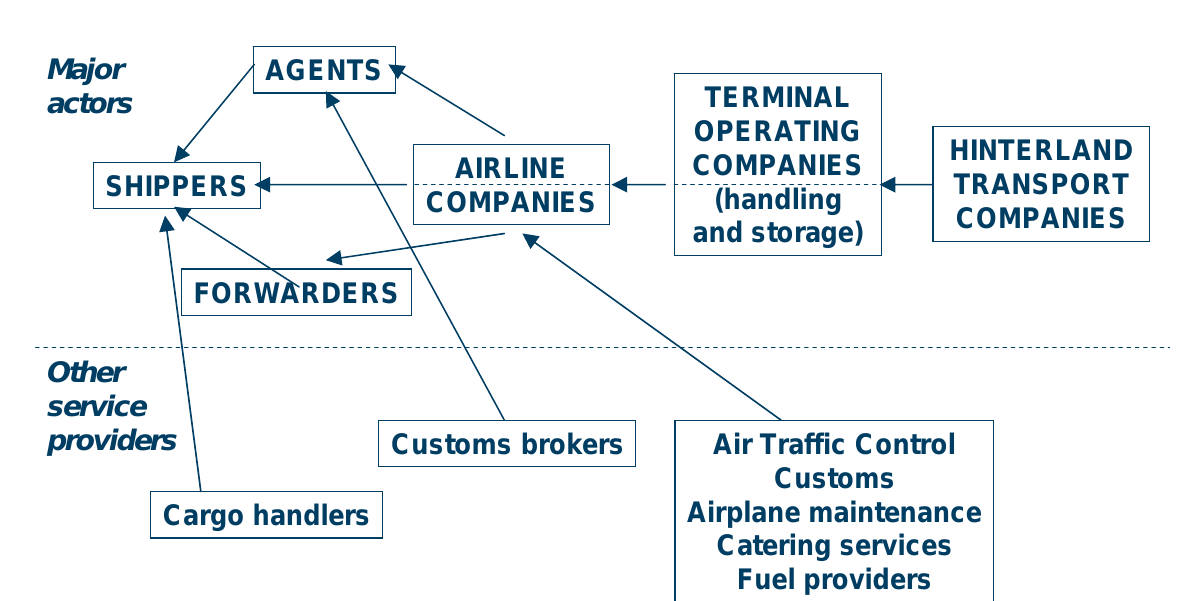
Figure 3. Air transport actors (cargo business case)